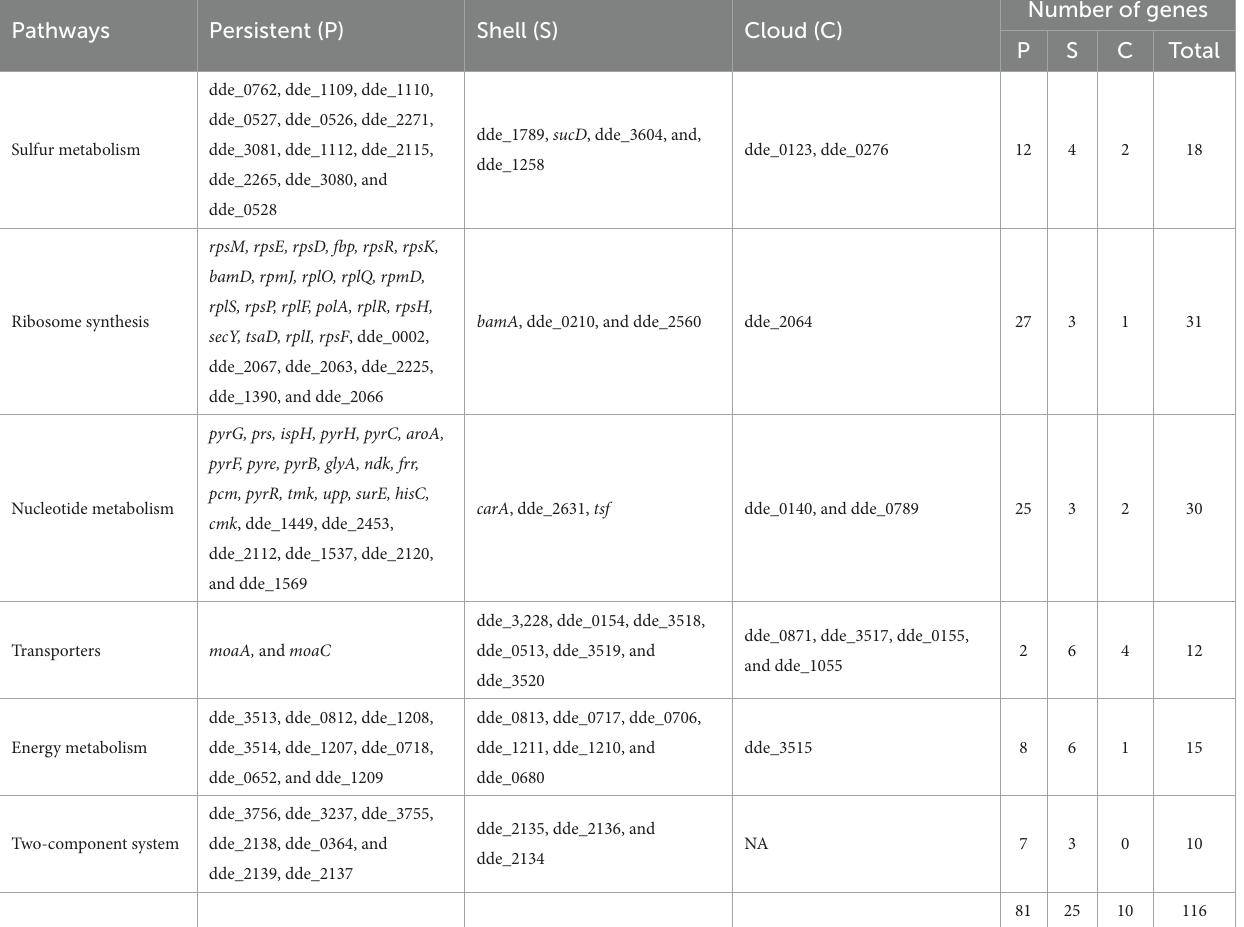
TABLE 3 Segregation of the genes based on the pangenome analysis (persistent, shell and cloud).